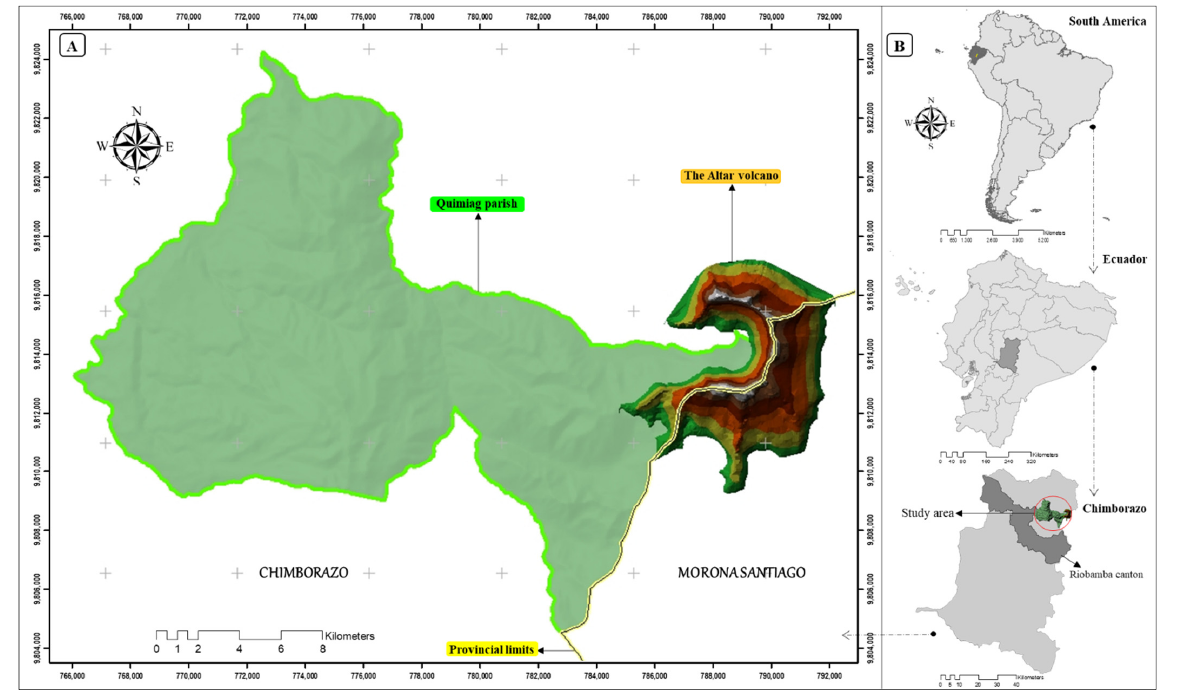
Figure 1. Map of the study area. ( A ) Altar Volcano location; ( B ) location in relation to Altar Volcano in South America, Ecuador, Chimborazo Province, and Riobamba Canton.